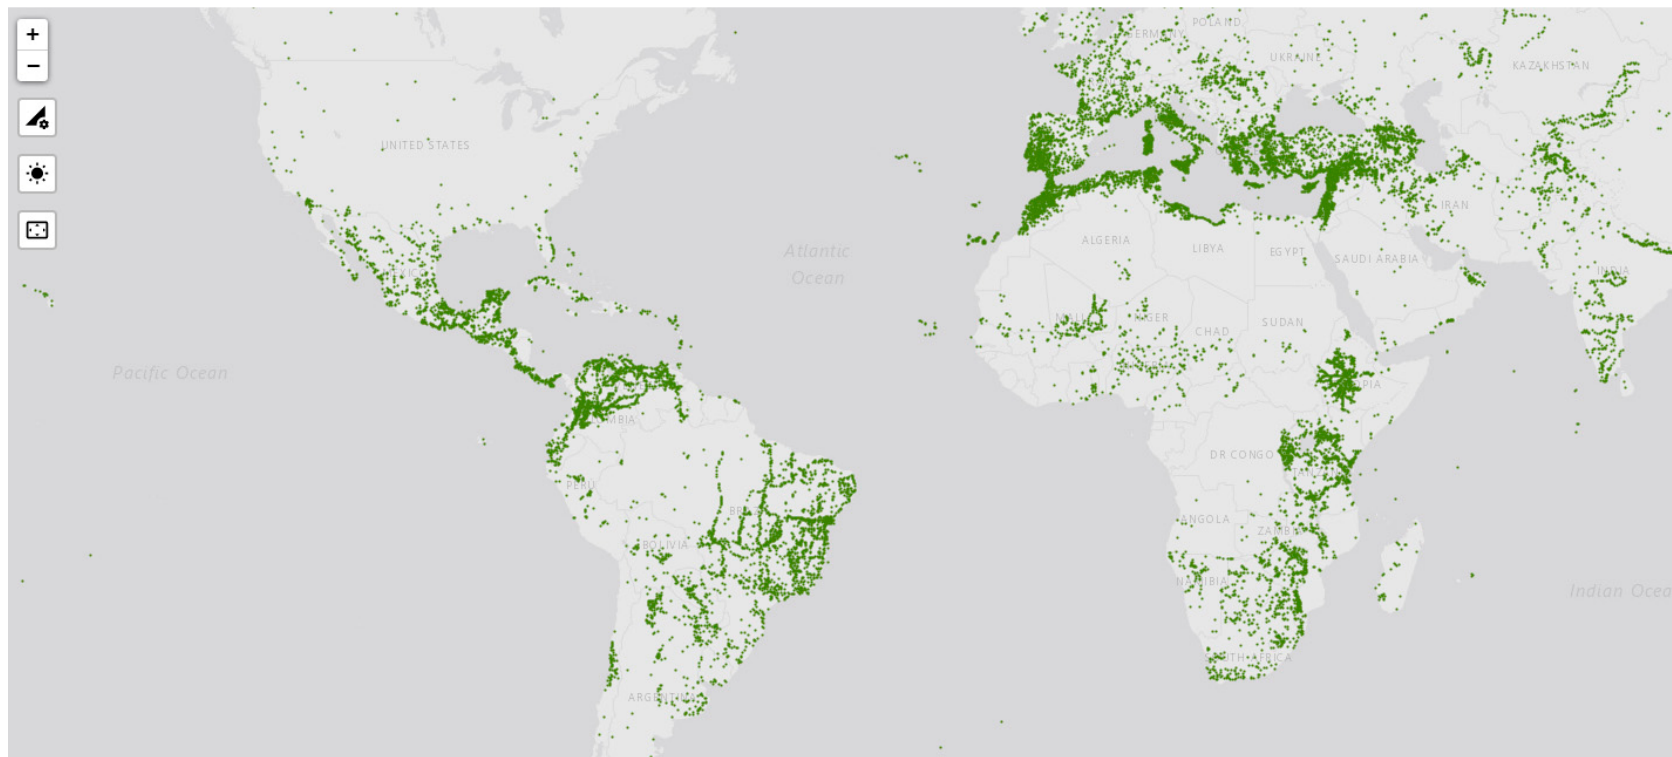
Figure 1. Map of forage accession collection sites. Data accessed through Genesys Global Portal on Plant Genetic Resources, www.genesys-pgr.org, 12 February